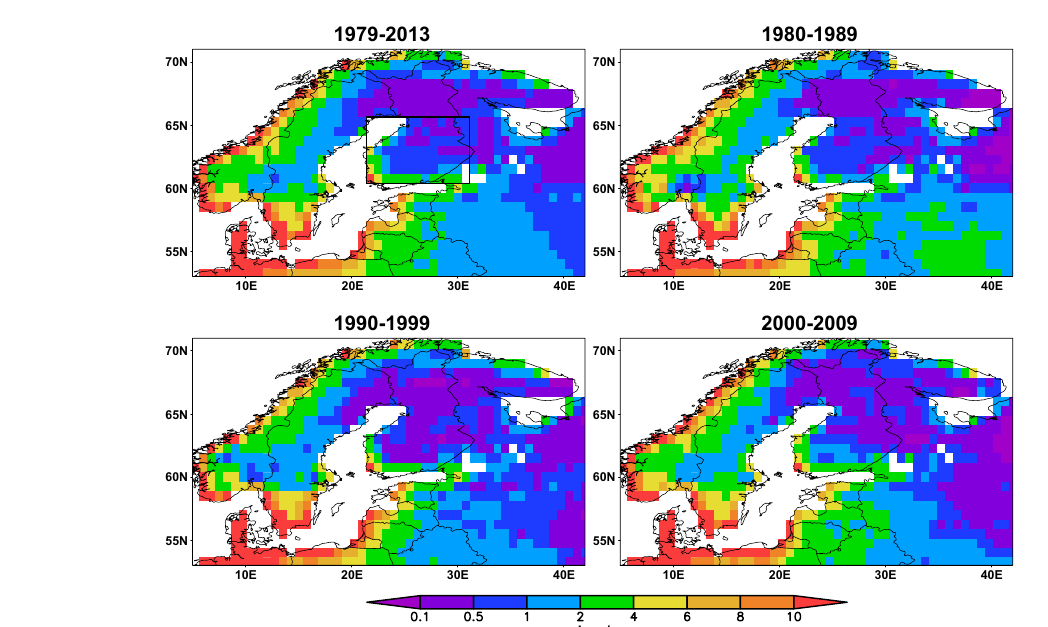
11.522.53 0.5 0 Figure 4. Blue columns are the average number of potential forest damage days in southern and central Finland based on ERA-Interim when wind gust and soil thresholds are met or exceeded. Vertical axis is on the left, and the red line is the 5-year running mean. The green dashed line is a 5-year running mean that uses the wind gust threshold only (vertical axis on the right). The values are calculated for the area depicted in Fig.